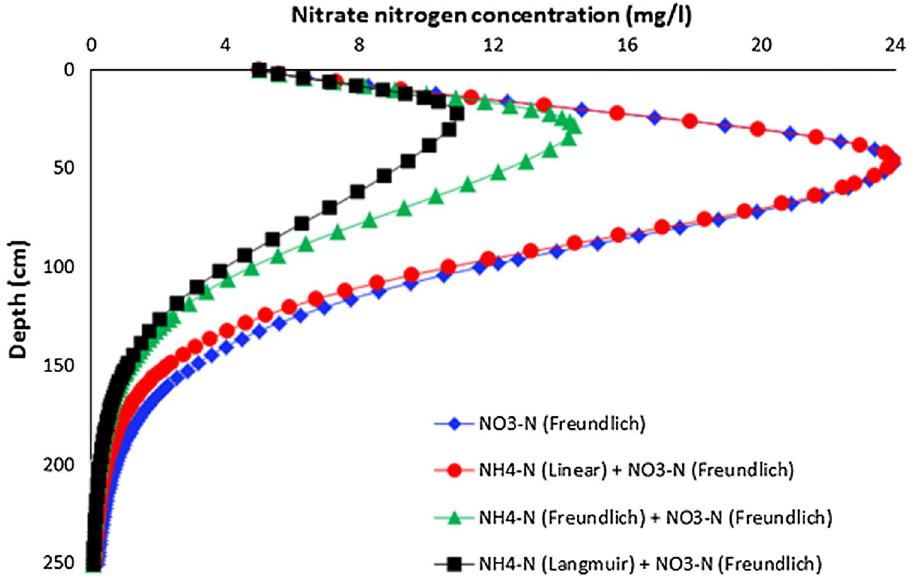
Fig. 9 Concentration of nitrate nitrogen in the presence of vari- ous isotherms by ammonium nitrogen and nitrate nitrogen (refer to Tables 2 and 3 for other